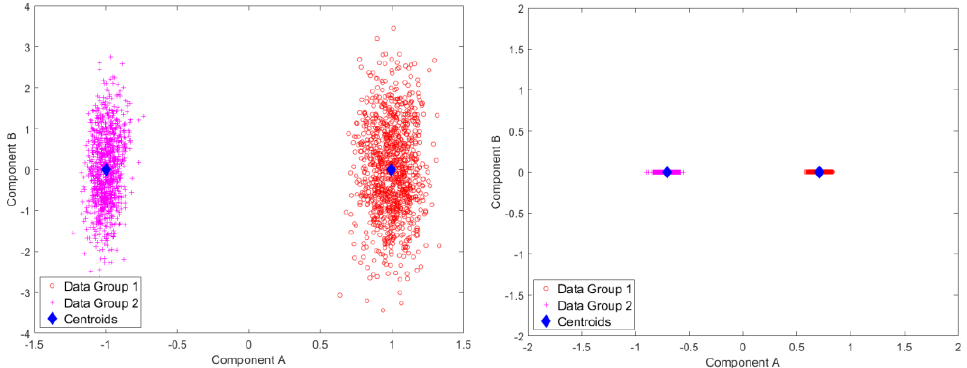
Figure 3. Results of standardized component scores for the test set of 1000 different trajectories per group in the test set for the Sine Wave dataset: ( left ) single-level, PCA; ( right ) level 1, mPCA. These results show strong clustering with respect to the two groups.